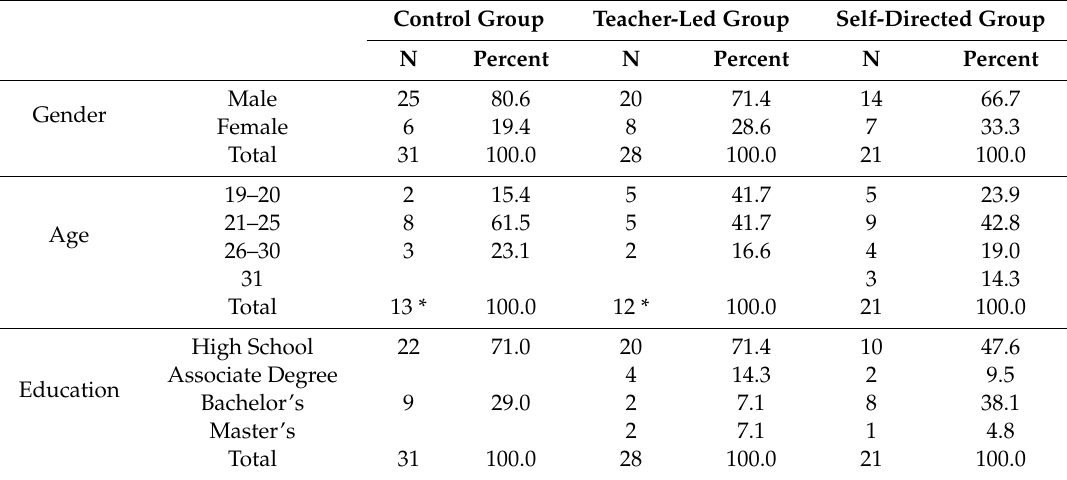
Table 1. Participants’ gender, age, and education